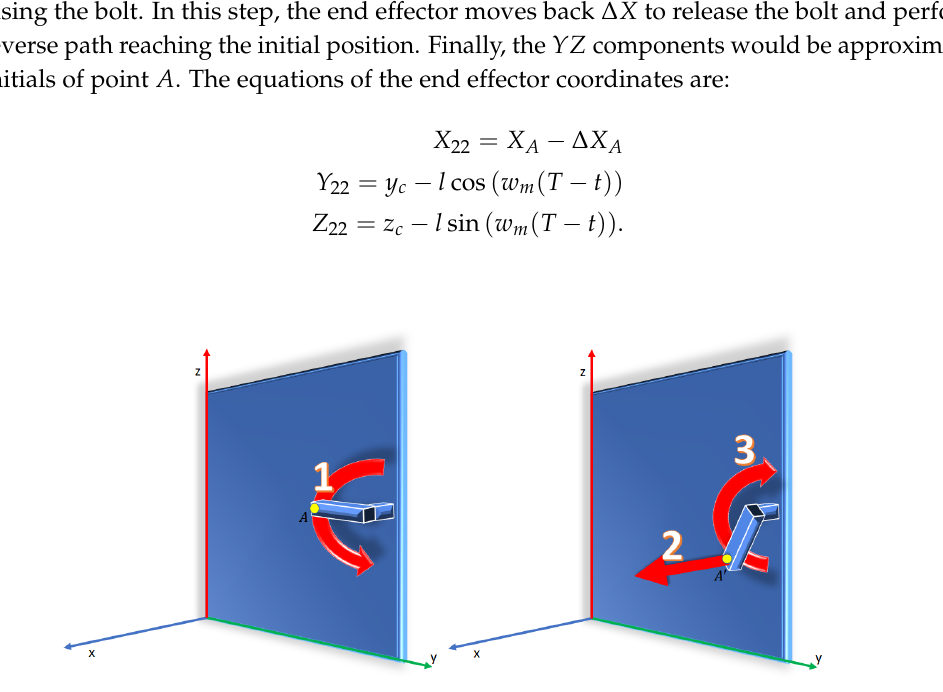
Figure 12. Movement of the end-effector in phase 2. (Left) The bolt is unlocked (1). (Right) The robot arm releases the bolt (2) and the handle returns to its initial position